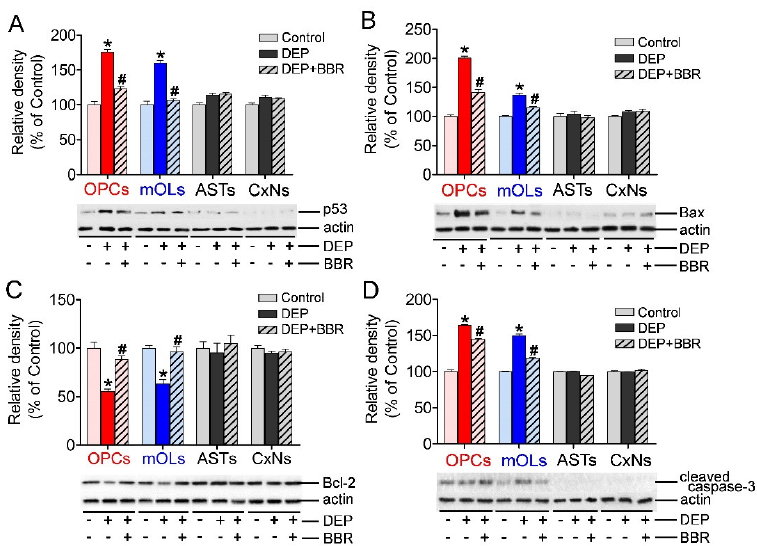
Figure 5. Expression of p53, Bax, Bcl-2, and cleaved caspase-3 in brain cells after exposure to ul- trafine DEP. The expressions of p53 ( A ), Bax ( B ), and cleaved caspase-3 ( D ) are significantly in- creased and the expression of Bcl-2 ( C ) is significantly decreased in OPCs and mOLs after exposure to ultrafine DEPs (200 μg/mL) compared with those in the control groups. However, BBR treatment significantly suppresses the expressions of p53 ( A ), Bax ( B ), and cleaved caspase-3 ( D ) and recovers the expression of Bcl-2 (C) in OPCs and mOLs exposed to ultrafine DEPs. There are no differences in the expressions of p53 ( A ), Bax ( B ), Bcl-2 ( C ), and cleaved caspase-3 ( D ) in astrocytes and cortical neurons in each group. ASTs = astrocytes, CxNs = cortical neurons. * p < 0.05 for DEP group vs. control, # p < 0.05 for DEP + BBR group vs. DEP group.